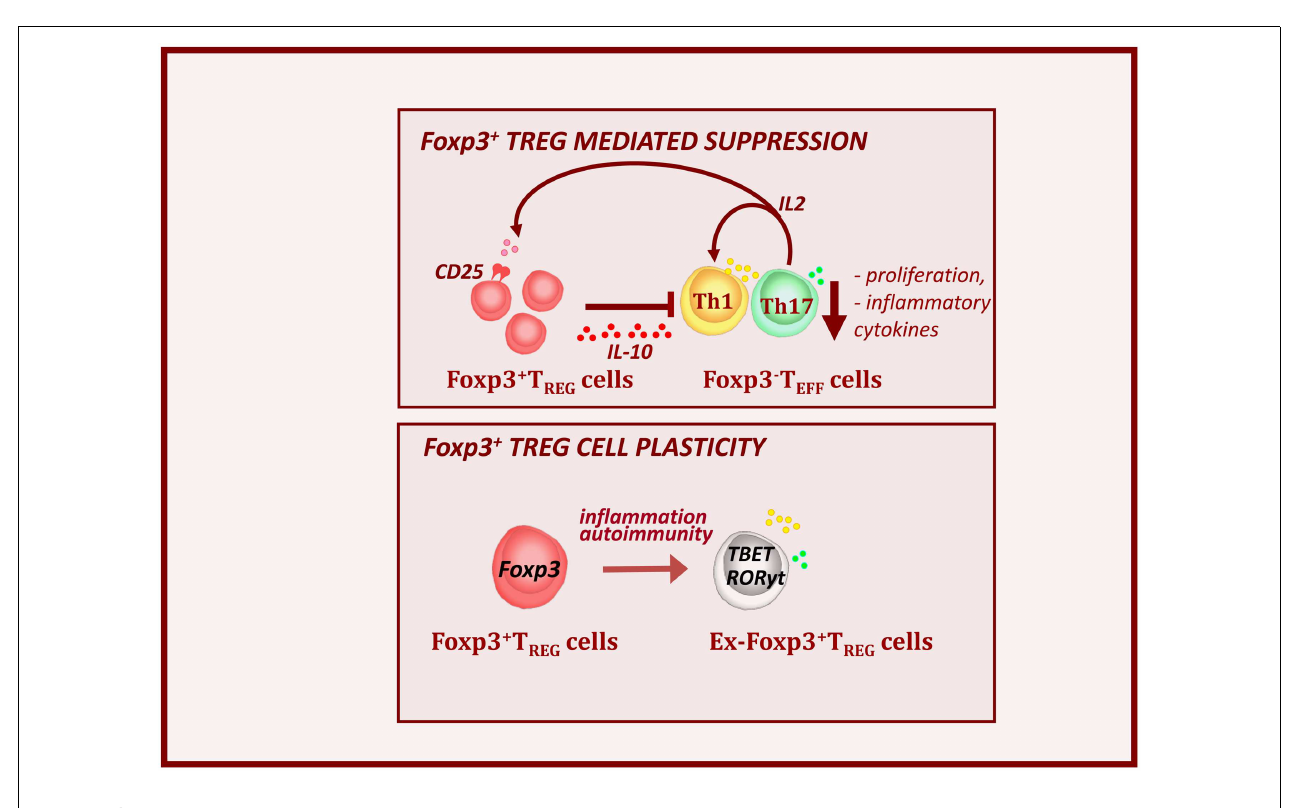
FIGURE 2 | Foxp3 + Treg cells control autoimmunity andT1D pathogenesis . Foxp3 + Treg cells express high levels of IL-2Ra or CD25 and are dependent onTeff-derived IL-2. Alterations in local IL-2 production may precipitateT1D by perturbingTreg cell function.Treg cells produce the immunosuppressive cytokine IL-10.This results to the down-regulation of inflammatory cytokines (IFNy and IL-17) and